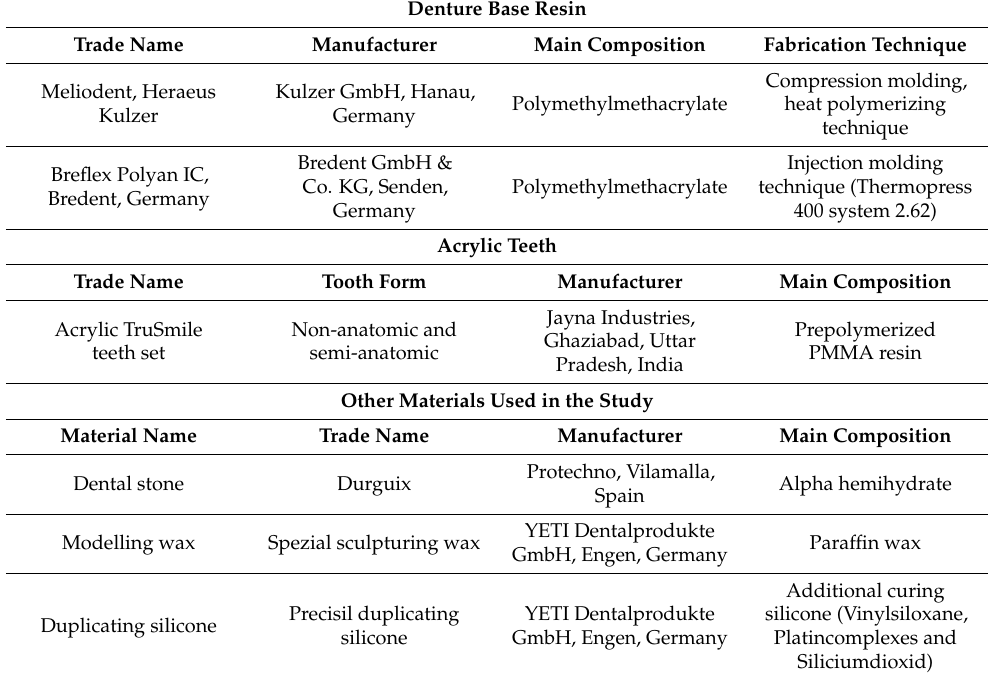
Table 1. Materials used in the study.